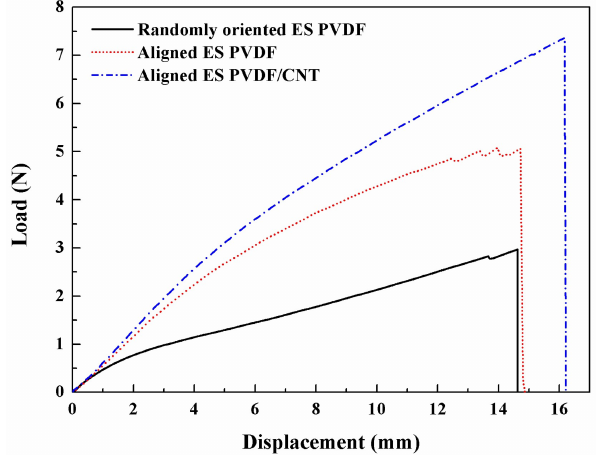
Figure 3. Tensile load-displacement curves of PVDF